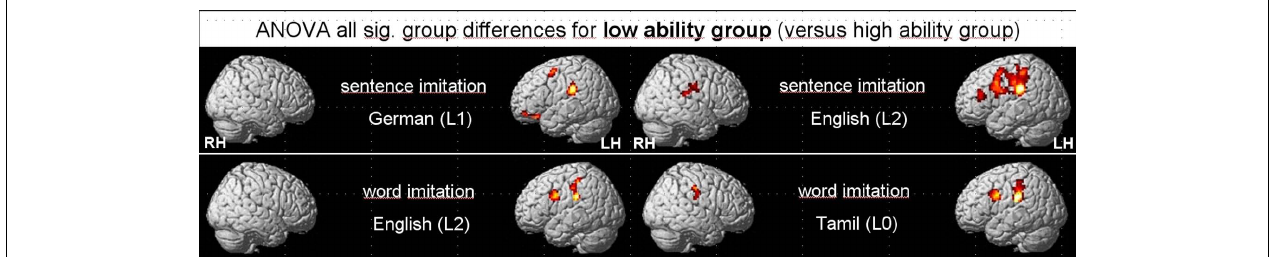
versus high ability”: significant suprathreshold activations emerging for the low ability group ( N = 9) – in “sentence imitation” (also in the case of L1 German), as well as in “word imitation.” A typical left-hemisphere dominant network comprising inferior parietal, premotor, and inferior frontal regions, emerges. In case of English in “sentence imitation” and Tamil in “word imitation” a right hemispheric centro-parietal cluster is additionally recruited. Statistical threshold: p < 0.05, whole-brain corrected for multiple comparisons at cluster level; cluster extent threshold: k = 60 voxels ( p = 0.05).